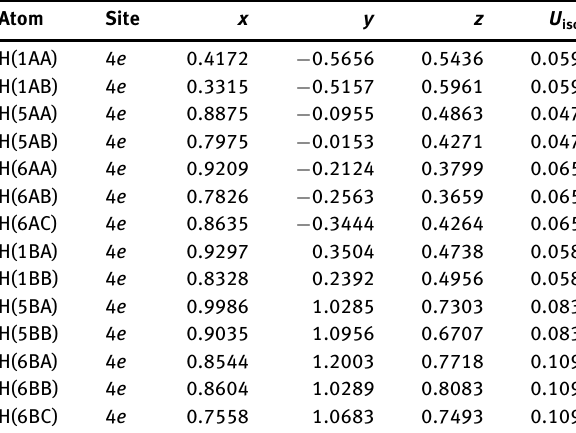
Table 2: Fractional atomic coordinates and isotropic or equivalent isotropic displacement parameters (Å 2